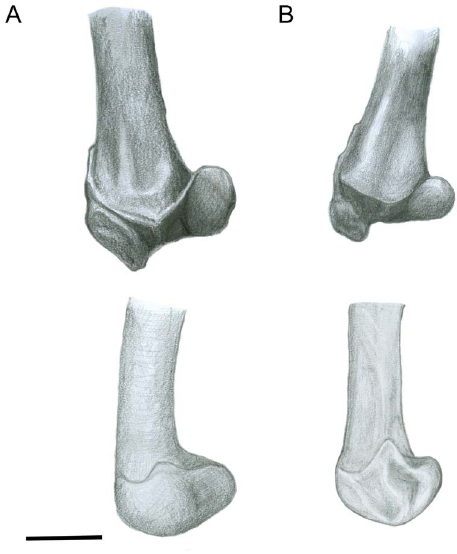
Figure 4. Femur. (A) Simosthenurus occidentalis (SAM: P17259). (B) Macropus sp. (SAM: P17270). All left side: upper = proximal articular view; lower = lateral distal view. Scale bar =5 cm.